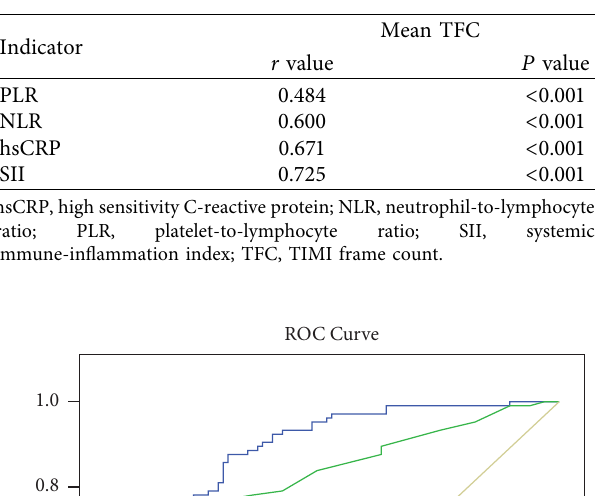
Table 4: Spearman’s rho correlation analysis between the mean TFC and infammation-based indicators.